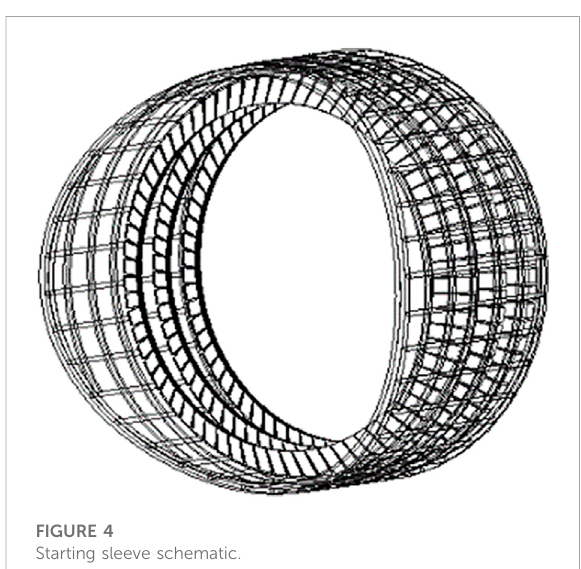
FIGURE 4 Starting sleeve